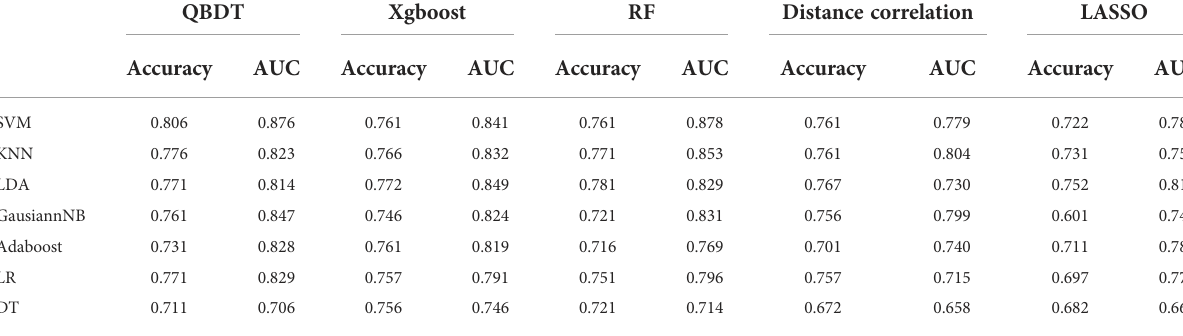
TABLE 2 Results of discriminative RMs in group 1 in the testing